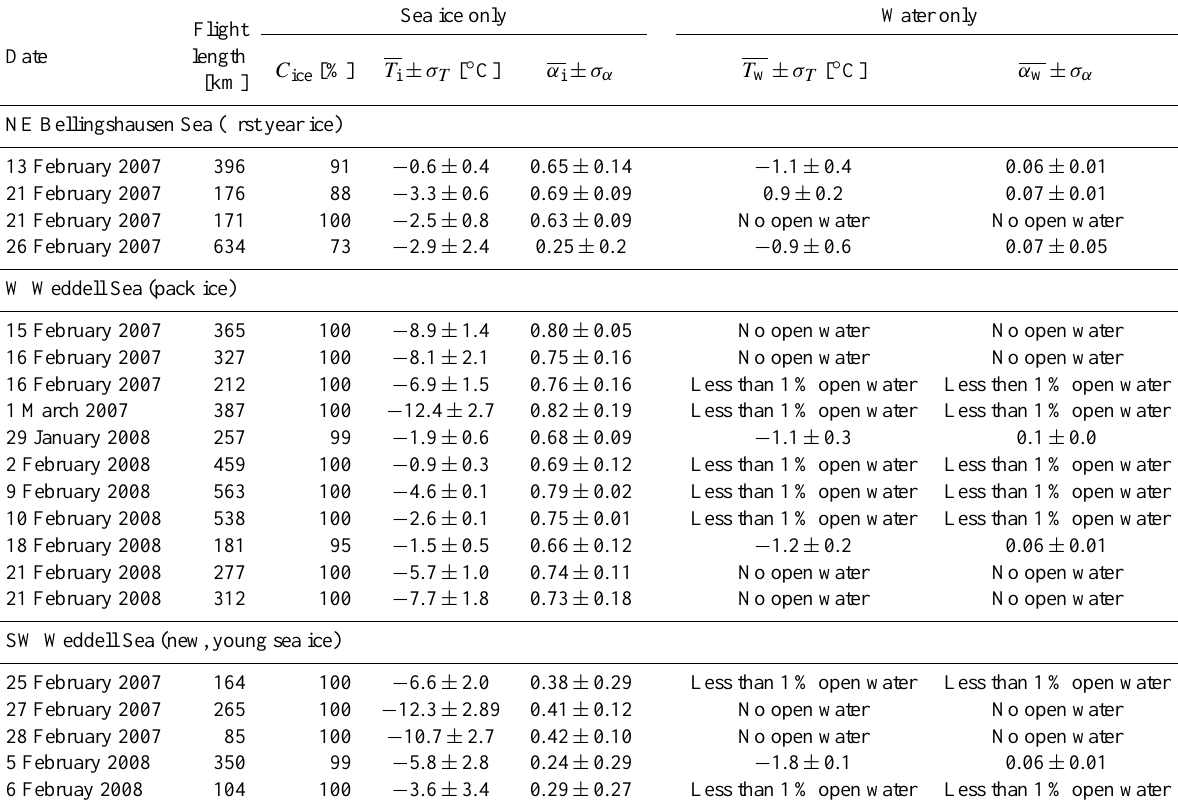
Table 1. Date and length of flight missions in the Weddell and Bellingshausen Seas and mean values (as median) of ice concentration C ice , sea ice temperature T i , water temperature T w , sea ice albedo α i , and sea water albedo α w , for each flight mission with their standard deviations σ